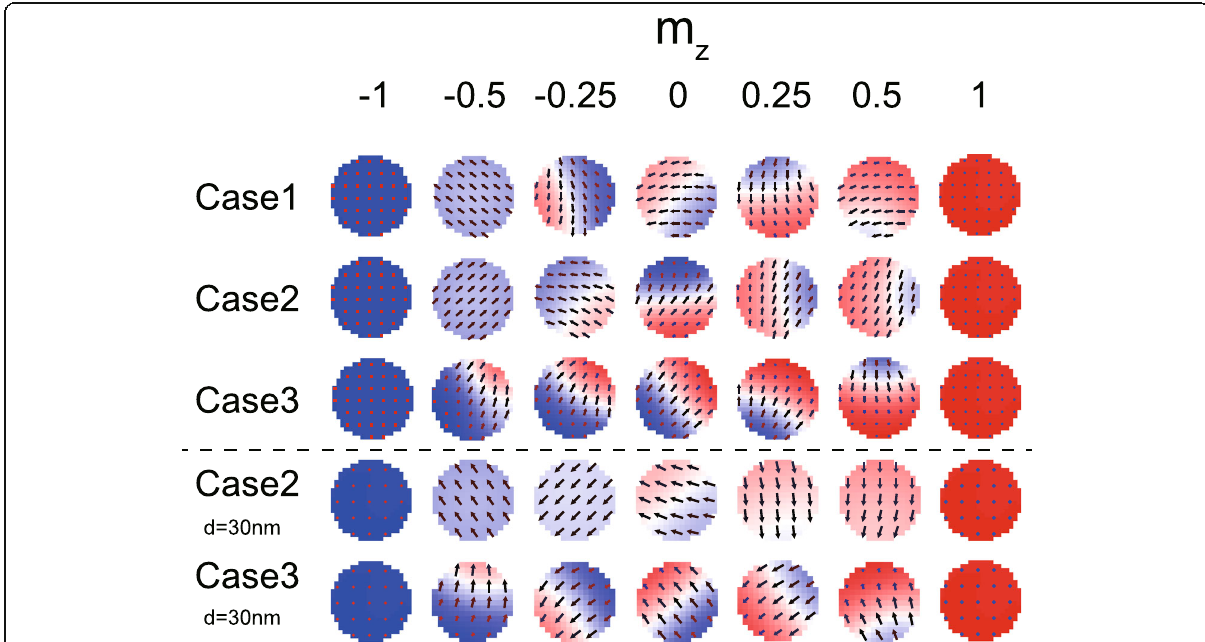
Fig. 7 Micromagnetic configurations during the magnetization switching. Here, cases 1~3 are configured with the same parameters as Fig.